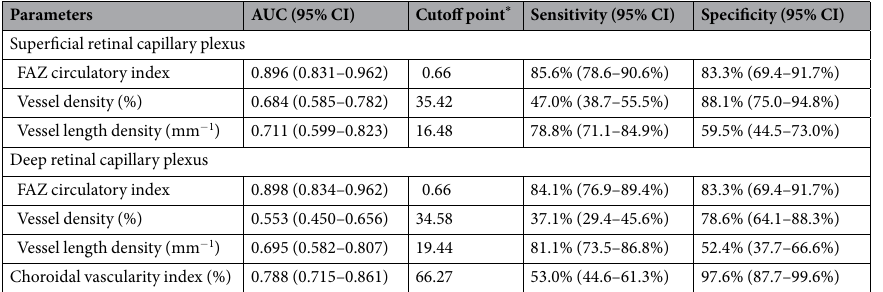
Table 3. ROC curve analysis of vascular parameters between eyes without DR and eyes with other DR stages. * Cutoff point based on the Youden Index. AUC, area under the curve; CI, confidence interval; DR, diabetic retinopathy; FAZ, foveal avascular zone; ROC curve, receiver operating characteristic curve.